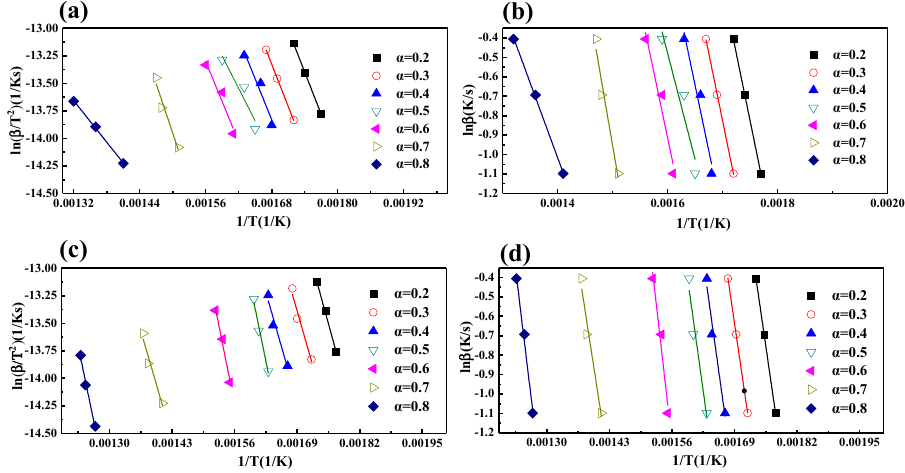
Figure 11. ( a ) The linear correlation of 30CVP70ATS by Kissinger–Akahira–Sunose (KAS); ( b ) the linear correlation of 30CVP70ATS by Ozawa–Flynn–Wall (OFW); ( c ) the linear correlation of ATS by KAS; and ( d ) the linear correlation of ATS by OFW.